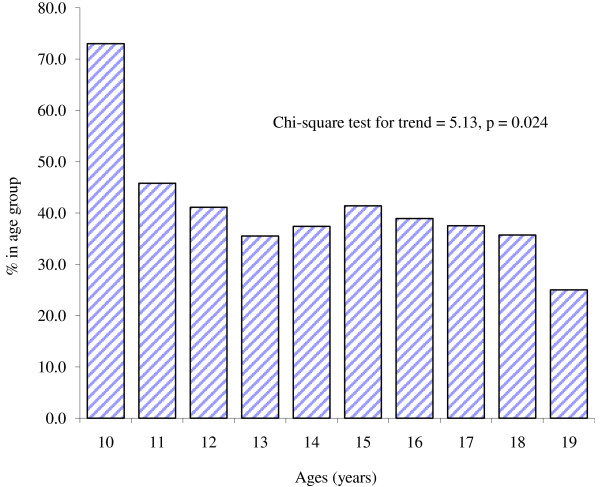
Trends of age-specific seroprevalence of protective immunity against tetanus.